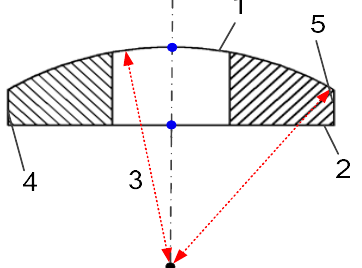
Figure 3. The sectional view of the permanent magnet (1—upper arc surface; 2—bottom surface; 3—radius of the upper arc; 4—left side; 5—right side).